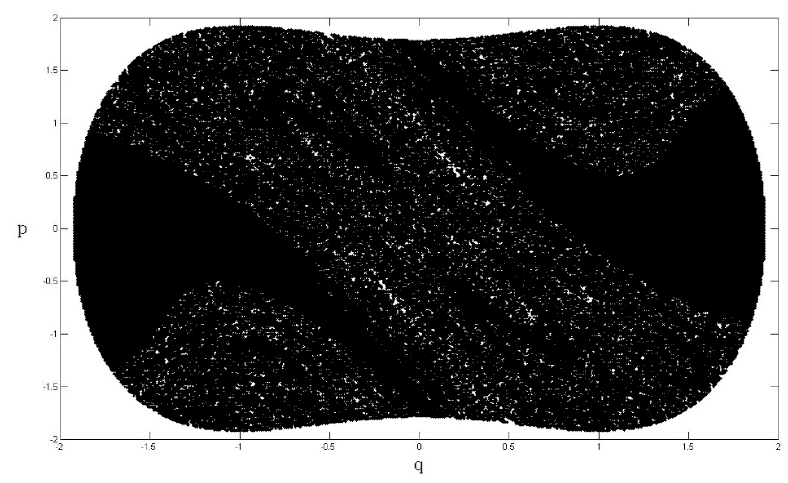
Figure 4. Safe basin of the system when e = 0.2.